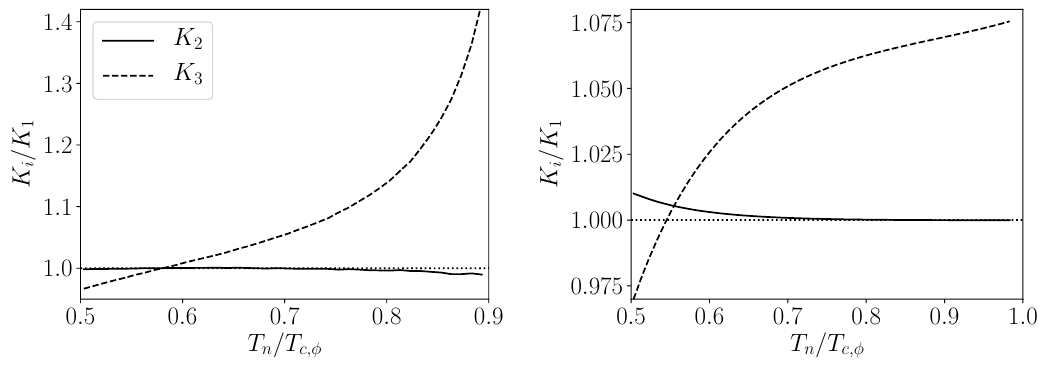
Figure 4 . Ratio of the kinetic energy fraction computed in Method 2 and Method 3 to the result of Method 1. The left plot shows a hybrid with v w = 0 . 65 and the right plot a detonation with wall velocity v w = 0 . 99